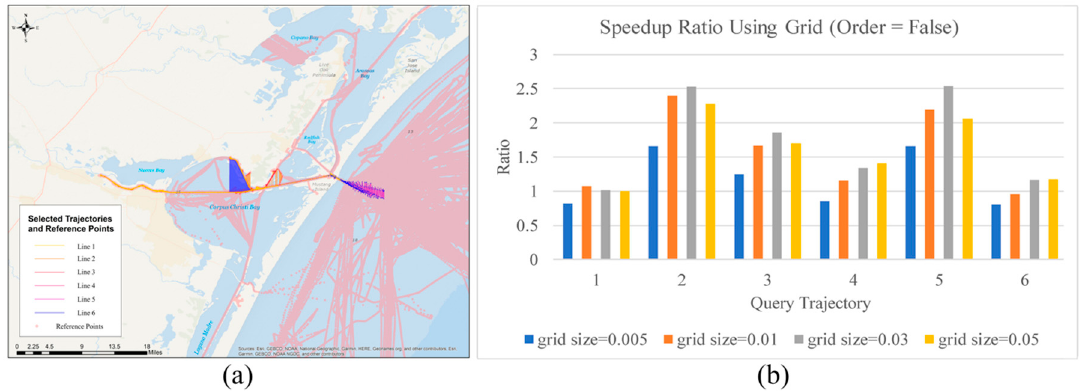
Figure 10. Comparing speedup ratio of AIS data (Group 3.a) using girds and without using grids: ( a ) The distribution of selected trajectories; ( b ) the comparison result.